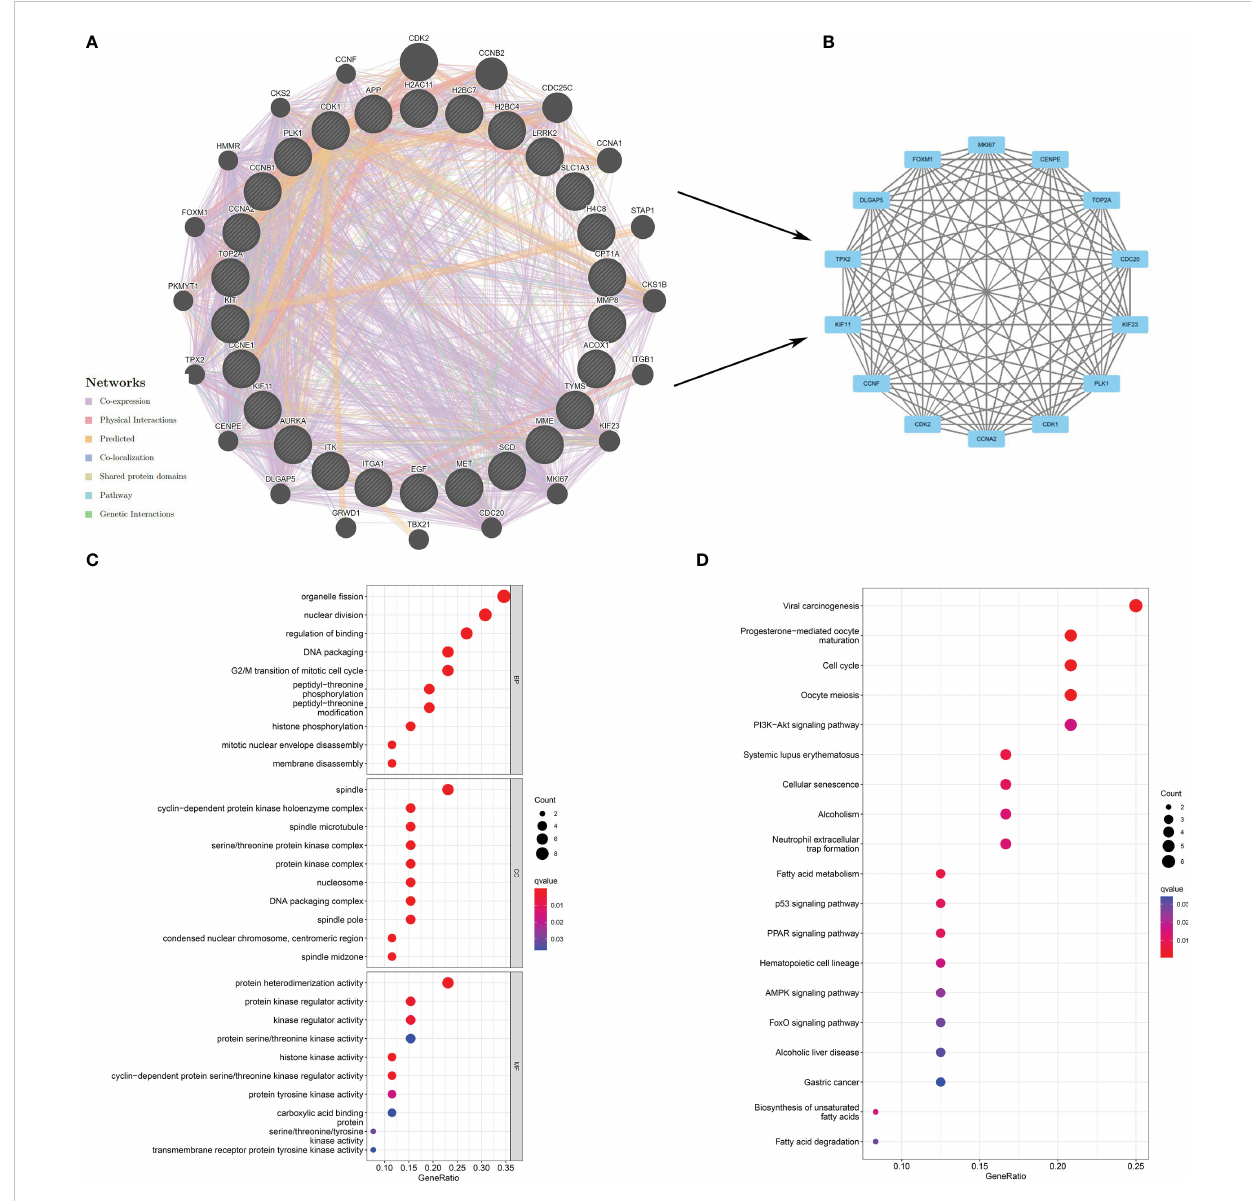
FIGURE 3 Exploration of the potential mechanism of berberine against KIRC/COVID-19. (A) The PPI network based on therapeutic target genes of berberine against KIRC/COVID-19. (B) the core network of PPI. (C) GO analysis of target genes. (D) KEGG pathway analysis of target